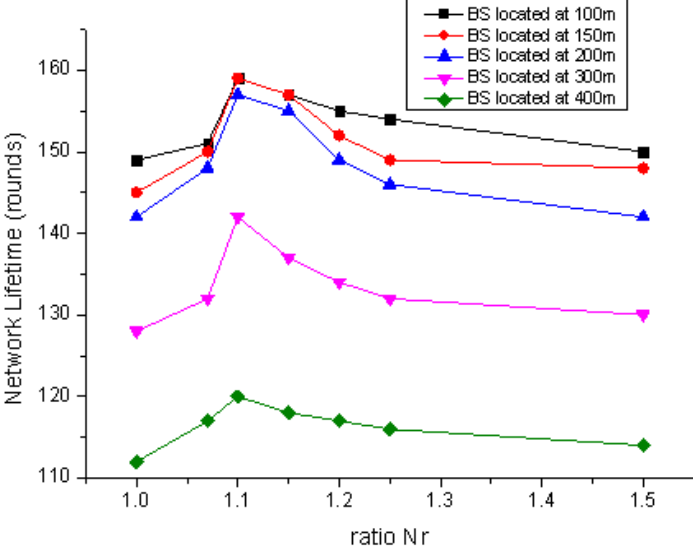
as BS is located 100 m, 150 m, r